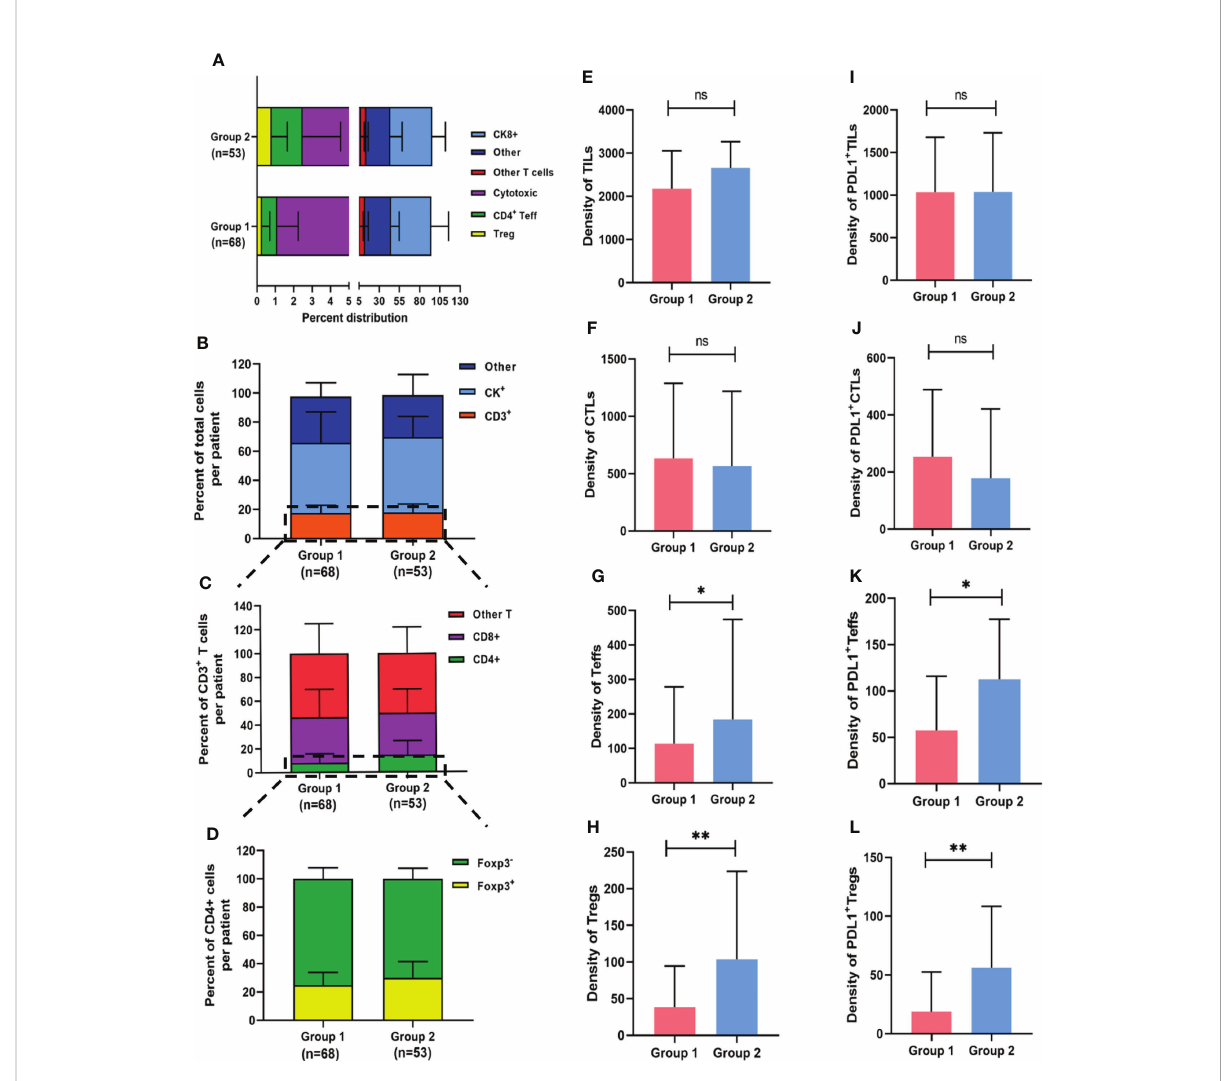
FIGURE 2 Composition of heterogeneous in fi ltrating immune cell subpopulations in Group 1 and Group 2. (A) Relative distribution of all analyzed cell phenotypes in NPC sample tissues. (B-D) Relative distribution analysis of different T cell subtypes between two groups, fi rstly by separating the total cell number into other, CK+ cells or CD3+ T cells (including all T cell subtypes) (B) ; then focusing on CD3+ T cells and dividing them into CD4+ T (CD3+CD4+), CD8+ (CD3+CD8+) and other (CD3+CD4-CD8-) cells (C) ; and fi nally focusing on CD3+CD4+ T cells and dividing them into Foxp3+ and Foxp3- T cells (D) . (E-H) Pairwise comparisons of the density of TIL subpopulations between the two groups for TILs (E) , CTLs (F) , Teffs (G) and Tregs (H) . (I-L) Pairwise comparisons of PDL1 positive TIL subpopulations between the two groups. * p < 0.05, ** p < 0.01, ns, not signi fi